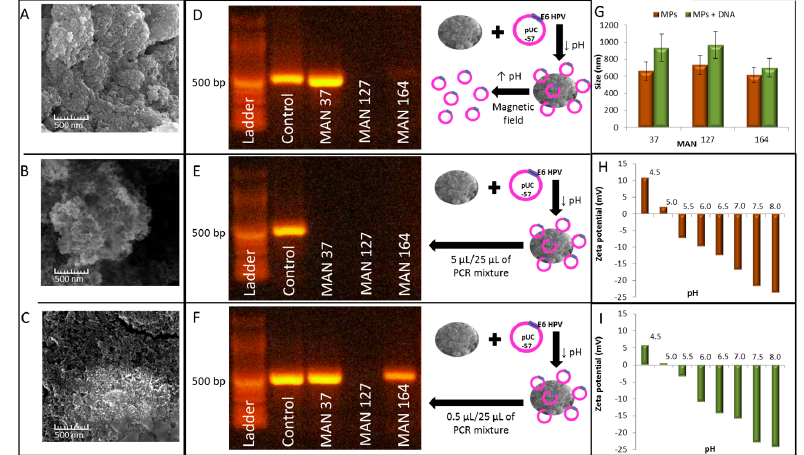
Figure 6. Isolation and detection of E6-HPV16-pUC57 plasmid using different “homemade” magnetiyable particles (MPs): ( A – C ) SEM microphotographs of MPs used in DNA isolation procedure (MAN-37, MAN-127 and MAN-164 respectively); ( D ) PCR amplification of E6-HPV16 gene in pUC-57 plasmid after elution from MPs; ( E ) PCR amplification of E6-HPV16 gene from 5 µL of MPs with bound DNA; ( F ) PCR amplification of E6-HPV16 gene from 0.5 µL of MPs with bound DNA; ( G ) the average size of MAN-37, 127 and 164 before and after binding with DNA; ( H ) the dependence of MAN-37 zeta potential on pH; and ( I ) the dependence of zeta potential of MAN-37 with bound DNA on pH.